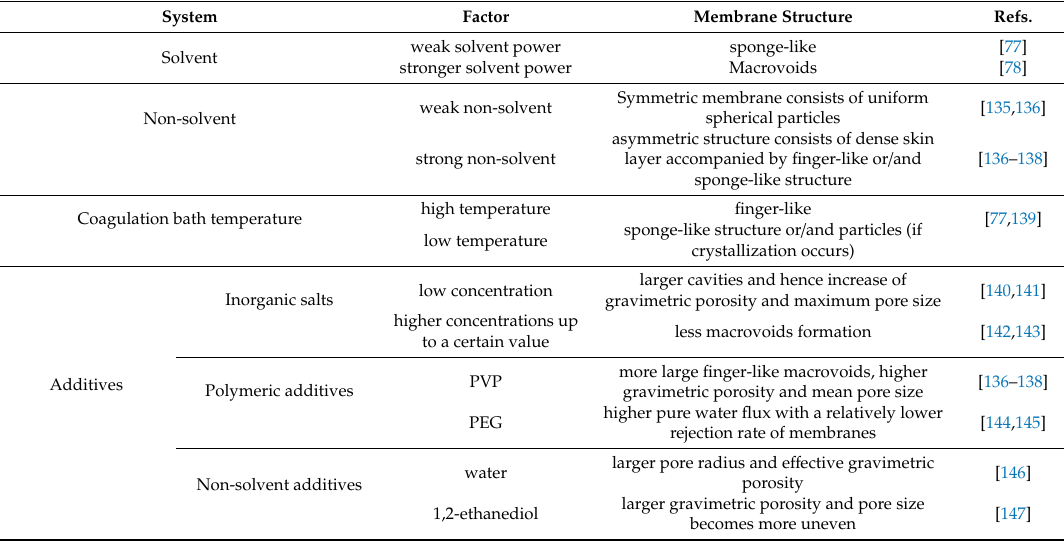
Table 5. E ff ects of various parameters on PVDF membrane morphology via